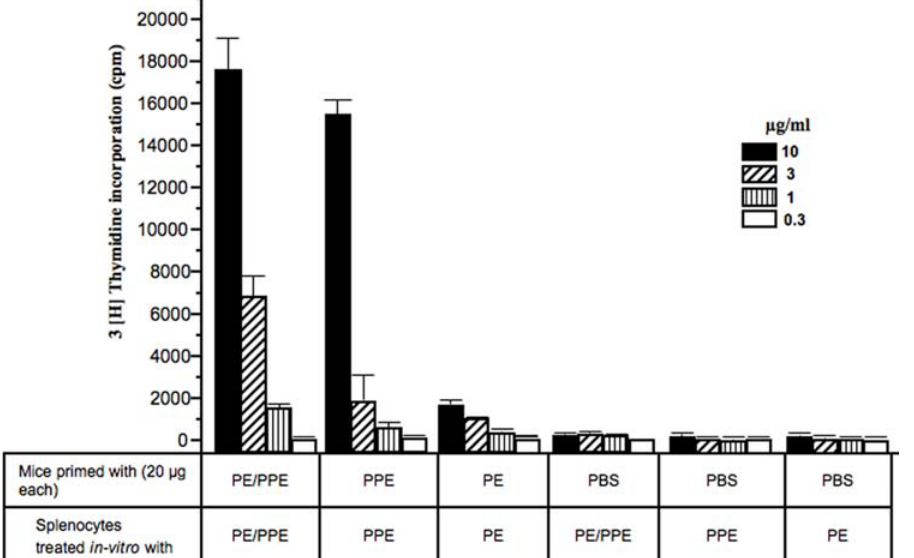
Figure 3. The PE25/PPE41 protein complex shows high splenocyte proliferation activity. Mice were injected with 20 m g each of the PE25, PPE41 and PE25/PPE41 proteins without any adjuvant. Splenocytes were isolated 4 weeks after the immunization with a booster dose at the second week and stimulated with corresponding proteins at different concentration in-vitro for 72 hours at 37 u C. The proliferation activity was measured by Thymidine incorporation assay. The Different bars (as indicated) show the total thymidine (cpm) incorporated in the splenocytes isolated from mice immunized with the PE25/PPE41 complex, PPE41, PE25 and PBS (as indicated), stimulated in-vitro with the different concentration of the respective proteins (as indicated). The data shown represent three independent experiments carried out in triplicate.